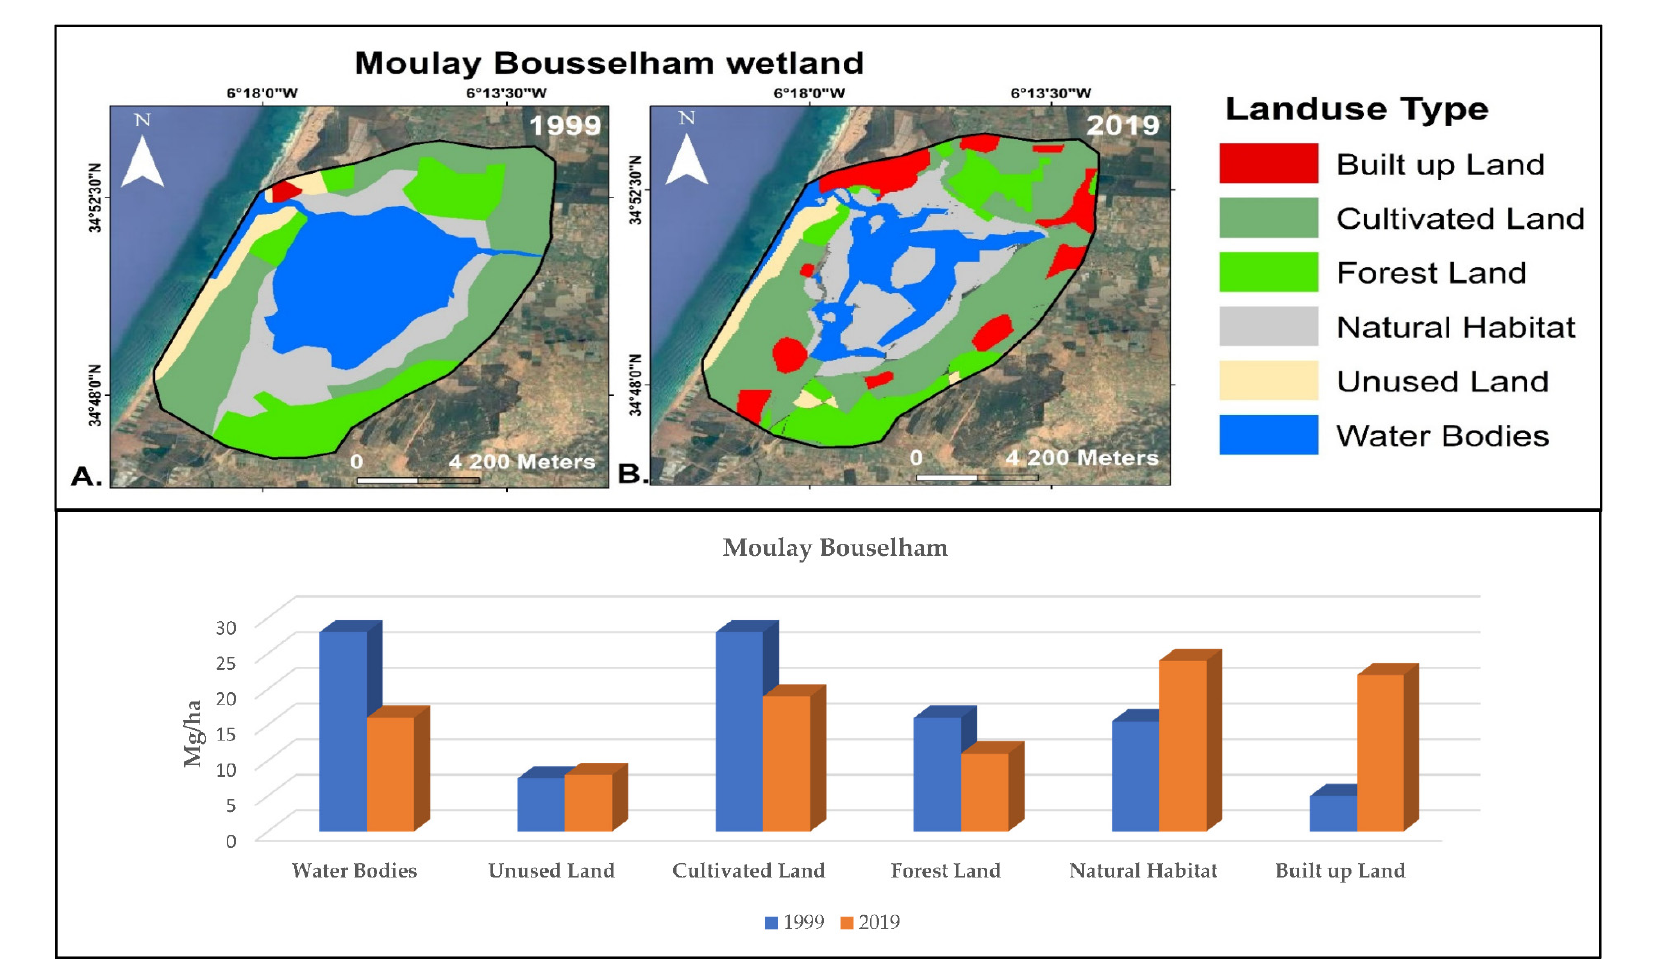
Figure 3. Maps and percentages of LULC changes in Moulay Bouselham between 1999 and 2019: ( A ) LULC change of 1999; ( B ) LULC change of 2019 .